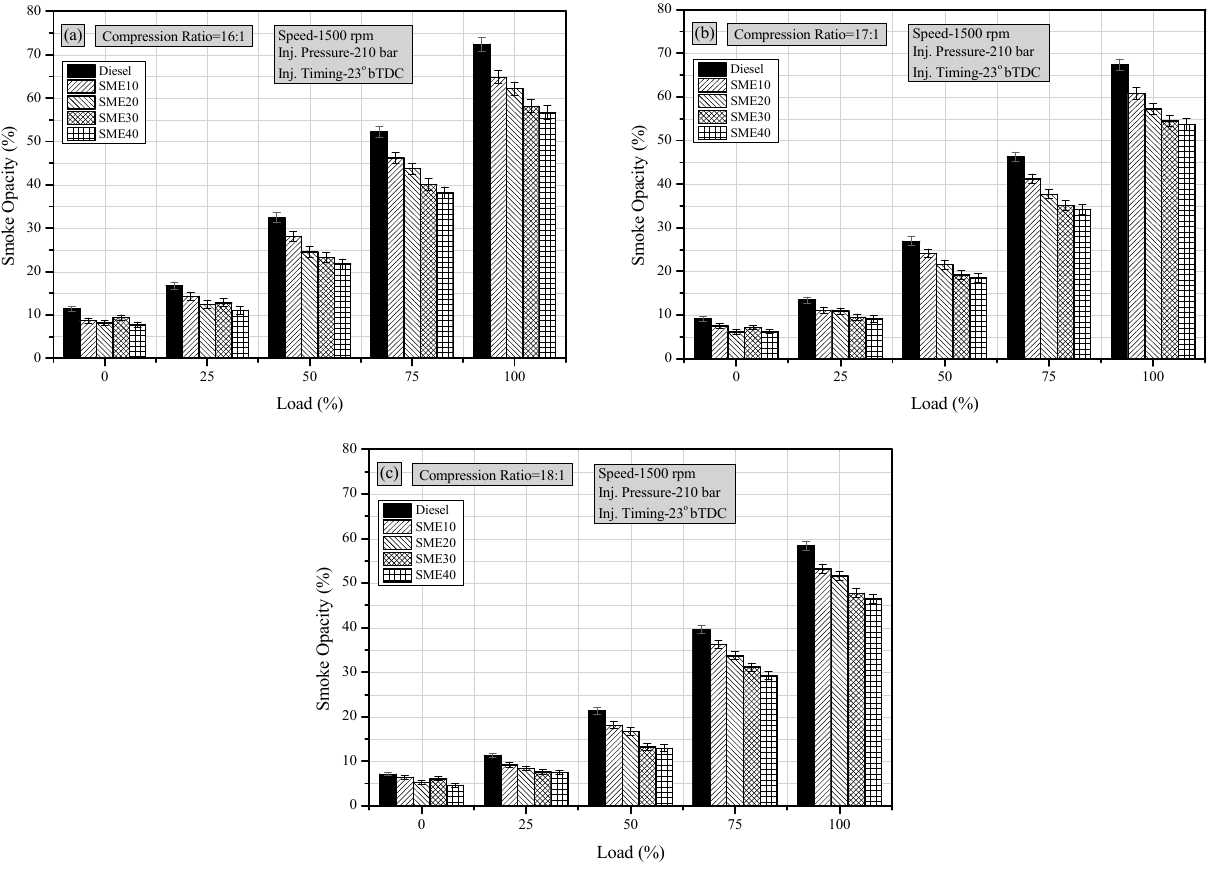
Figure 10. Variation of smoke opacity with load for the fuel blends at CRs: ( a ) 16:1 ( b ) 17:1 ( c ) 18:1. Factors such as oxygen content, combustion temperature, and reaction residence time are crucial in the production of NO x emissions. Incomplete combustion brought on by low cylinder temperature and low oxygen concentration, which slow the local oxidation reactions, also contributes to the creation of the CO emission. Additionally, the main causes of HC emissions include the following: firstly, due to valve overlap during the gas ex- change, the unburned mixture in the cylinder escapes into the exhaust port; secondly, as the exhaust valves open, the unburned mixture is forced into the combustion chamber’s cracks and discharged, creating the HC emissions; thirdly, during the expansion stroke, particularly during cold starts, the unburned mixture is discharged from the lubricating oil that is utilized to lubricate the piston and piston rings. The combustion chamber’s crev- ices are primarily responsible for the generation of HC emissions [65].